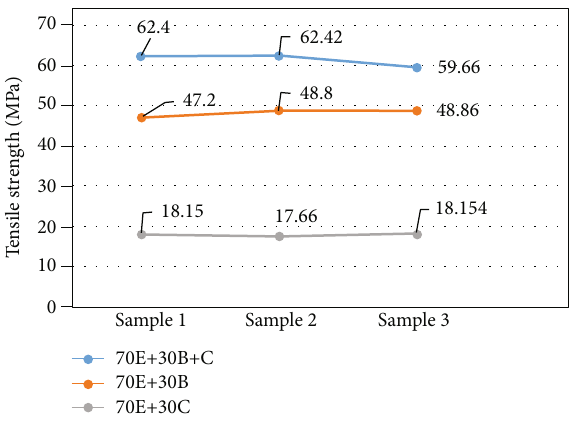
Figure 3: Samples testing for tensile